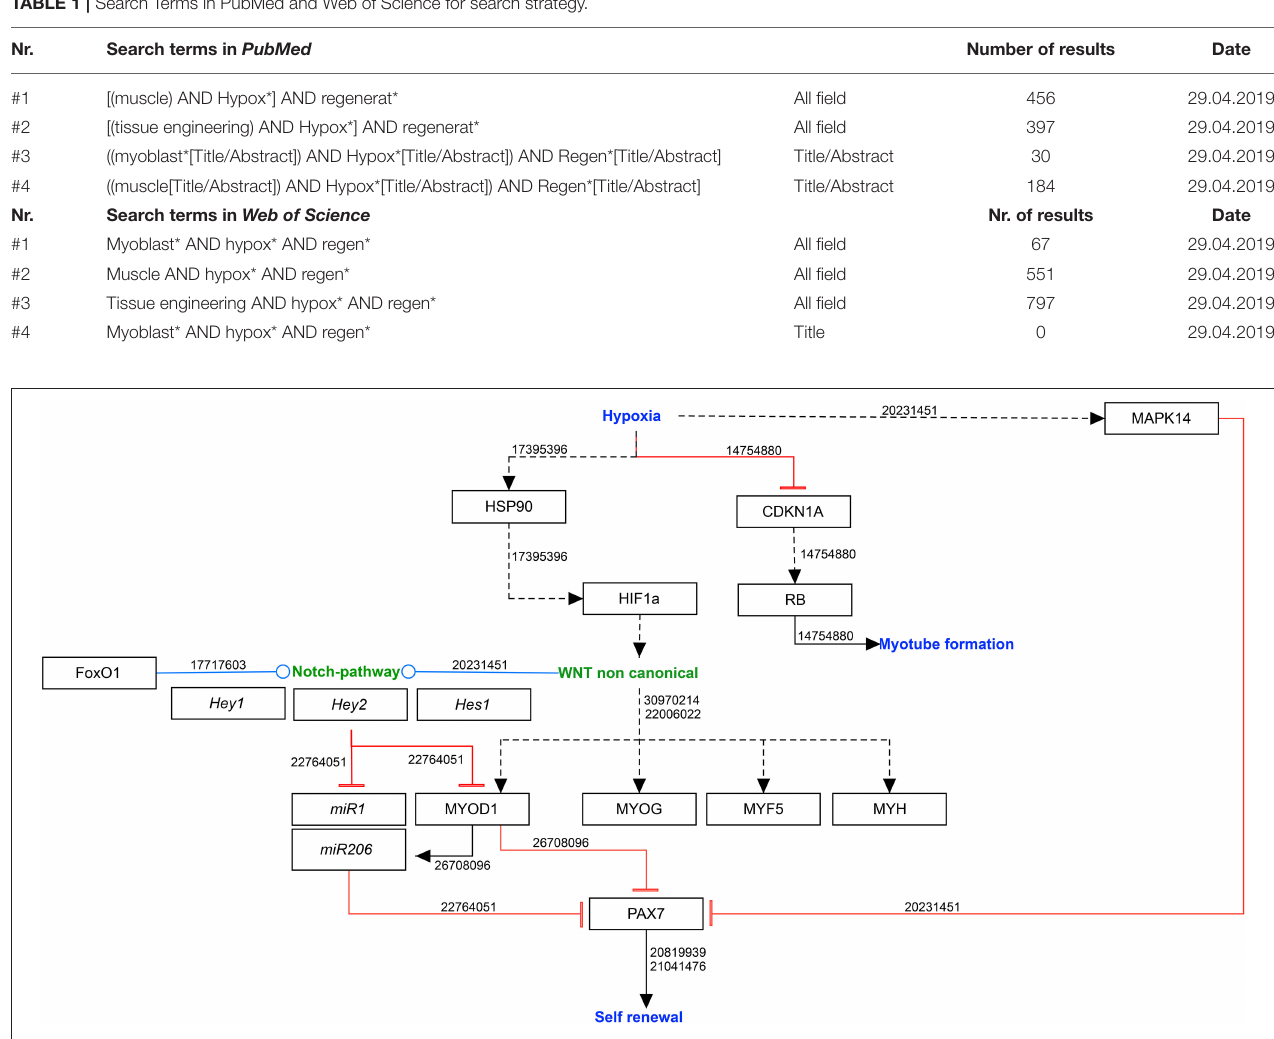
TABLE 1 | Search Terms in PubMed and Web of Science for search strategy.